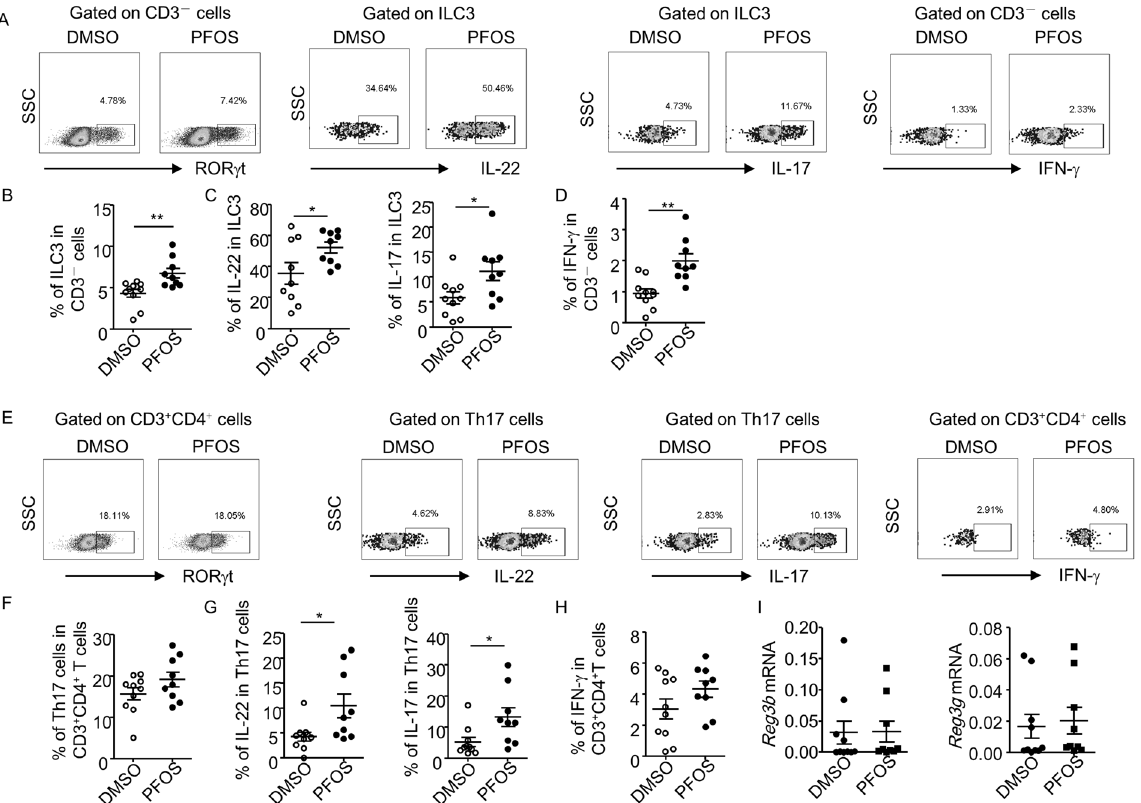
Figure 5. PFOS promotes both innate and adaptive production of IL-17 and IL-22 at late phase of C. rodentium infection. On day 12 post C. rodentium infection, large intestinal lamina proprial lymphocytes were isolated from each group and analyzed by flow cytometry. Cells were stimulated with PMA and ionomycin for 4 hr before analysis. ( A and E ) The expression of CD3, CD4, ROR γ t, IL-17, IL-22 and IFN- γ was analyzed by flow cytometry. ( B ) Percentages of ILC3 (CD3 − ROR γ t + cells) gated on CD3 − cells were shown. ( C ) Percentages of IL-22 and IL-17 expression gated on ILC3 were shown. ( D ) Percentages of IFN- γ gated on CD3 − cells were shown. ( F ) Percentages of Th17 cells (CD3 + CD4 + ROR γ t + cells) gated on CD3 + CD4 + cells were shown. ( G ) Percentages of IL-22 and IL-17 production gated on Th17 cells were shown. ( H ) Percentages of IFN- γ gated on CD3 + CD4 + cells were shown. Horizontal lines show the mean. Error bars represent SEM. Data were pooled from three independent experiments. ( I ) mRNA expression of RegIII β and RegIII γ in colon tissues was analyzed using realtime RT-PCR. Statistical analyses were performed using Mann-Whitney unpaired U test. Horizontal lines show the mean. Error bars represent SEM. Data are representative of two independent